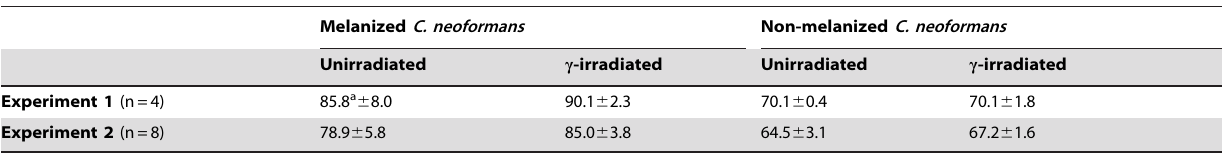
Table 1. 213 Bi binding to C. neoformans